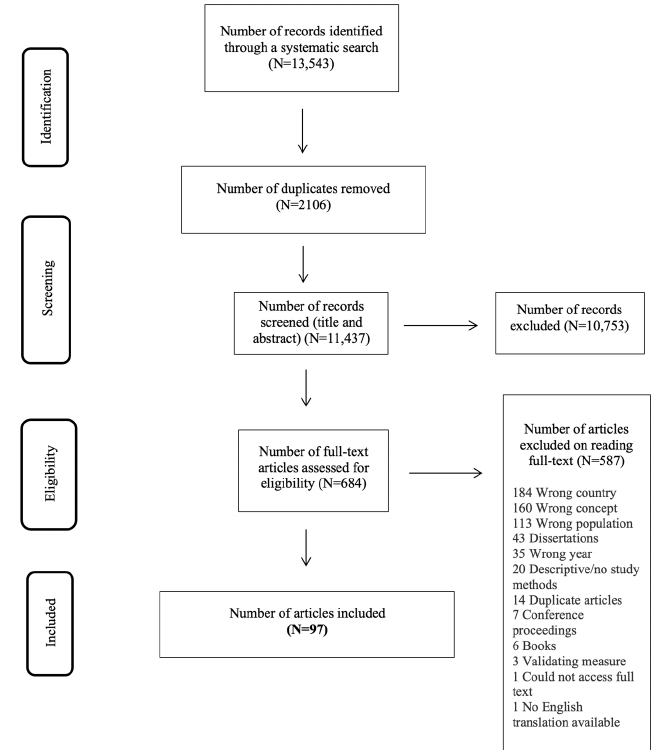
Figure 1. PRISMA flow diagram of search and study selection process [16].